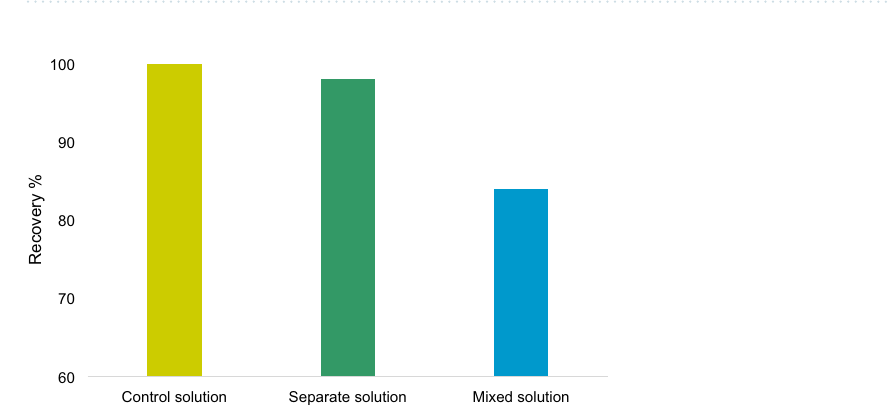
Figure 2. Recovery percentage of BPA from the solution compared to a standard BPA solution and impact of colloidal particles’ concentration on BPA’s extraction.